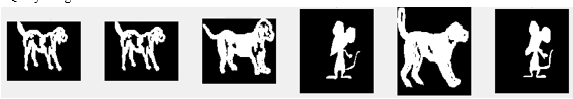
Figure 8. Final resultant fused image(Dataset MPEG-7)